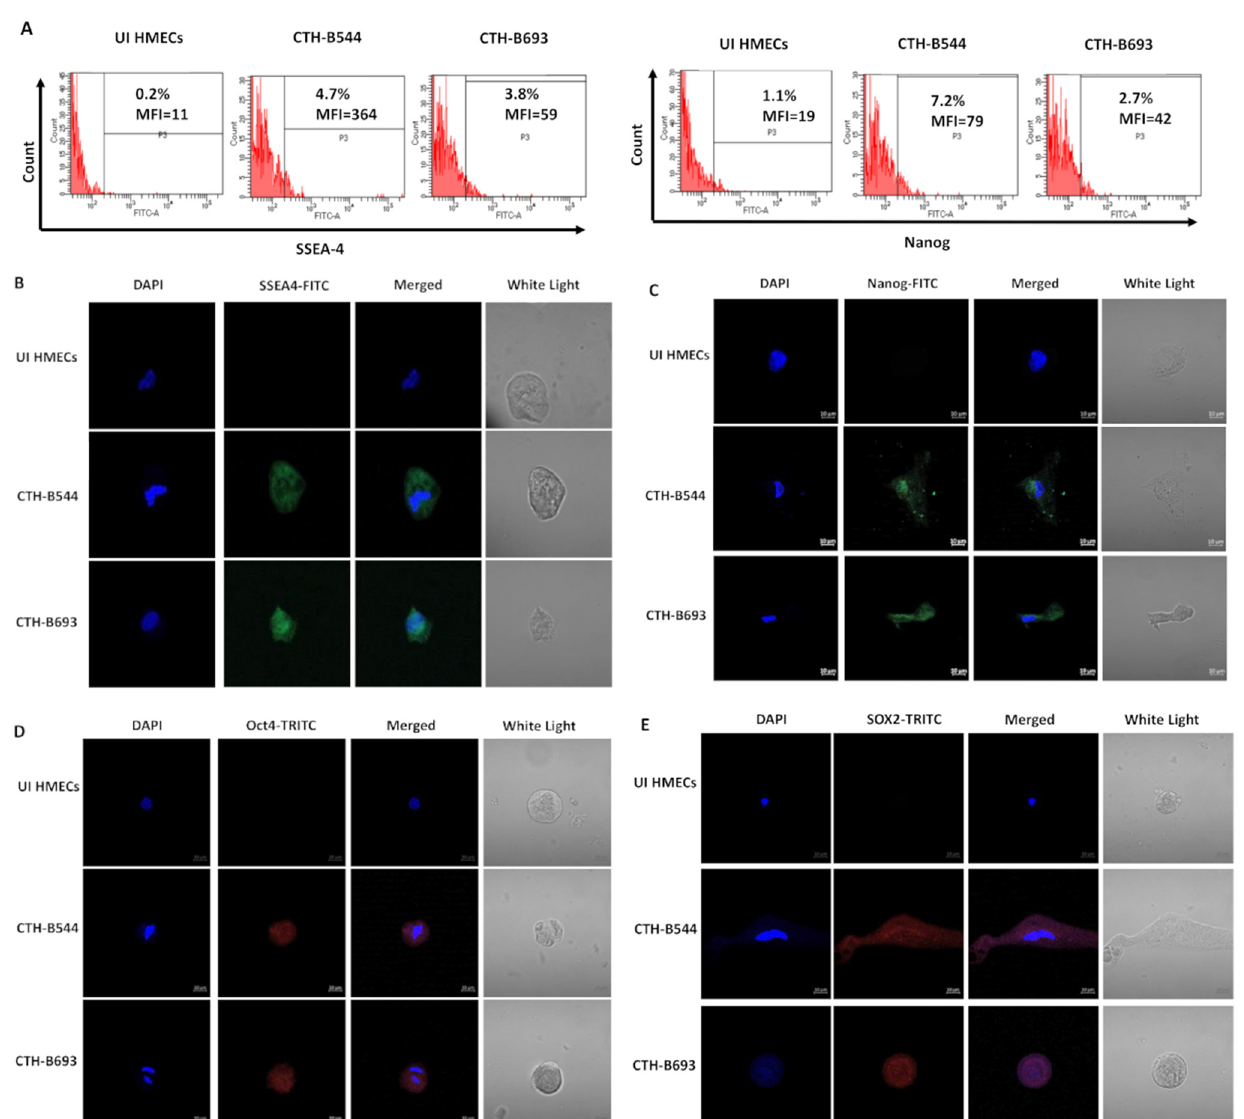
Figure 5. Expression of embryonic stem cell markers in CTH-B544 and B693 cells. ( A ) Detection of SSEA4 and Nanog in CTH cells by FACS. Results are representative of three independent experiments. Confocal microscopy imaging demonstrating the expression of ( B ) SSEA-4, ( C ) Nanog, ( D ) Oct4, and ( E ) SOX2. Nuclei were counterstained with DAPI; magnification ×63, scale bar 10 μ m.